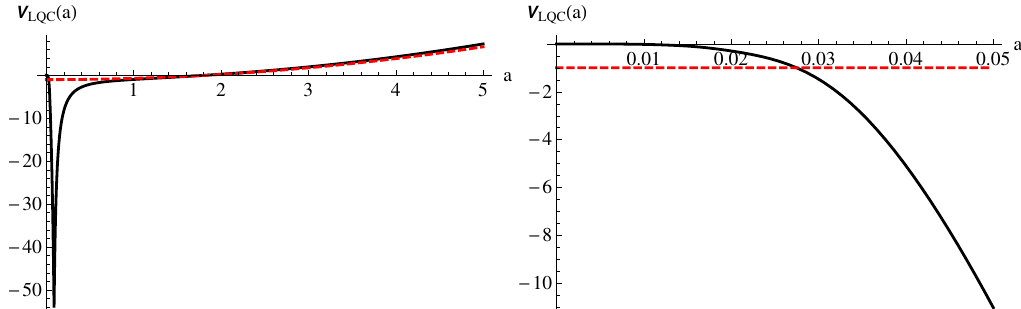
(Figure 7) in terms of the fundamental parameters—Planck length and Immirzi parameter—of the theory, as shown via numerical reconstruction.